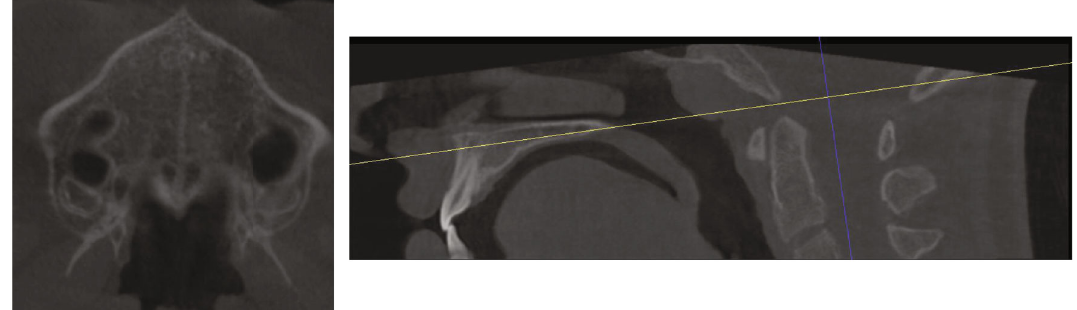
Figure 5: CBCT suture evaluation.